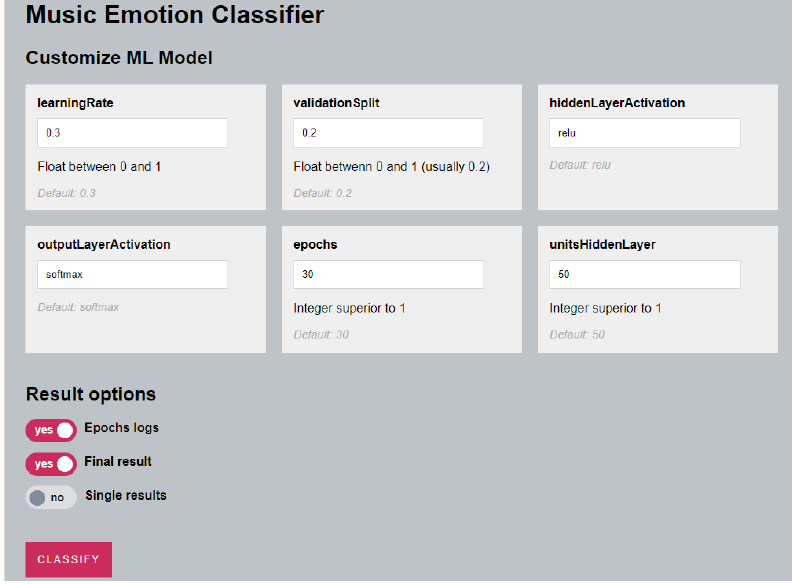
Figure 7. Model Training Web Application UI.